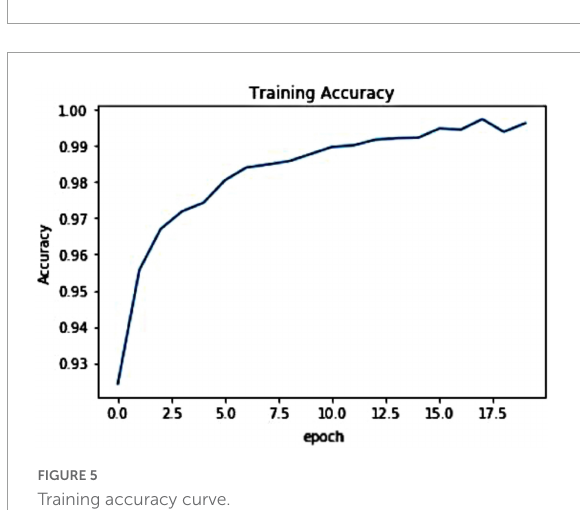
FIGURE4 Pictorial demonstration of training loss.